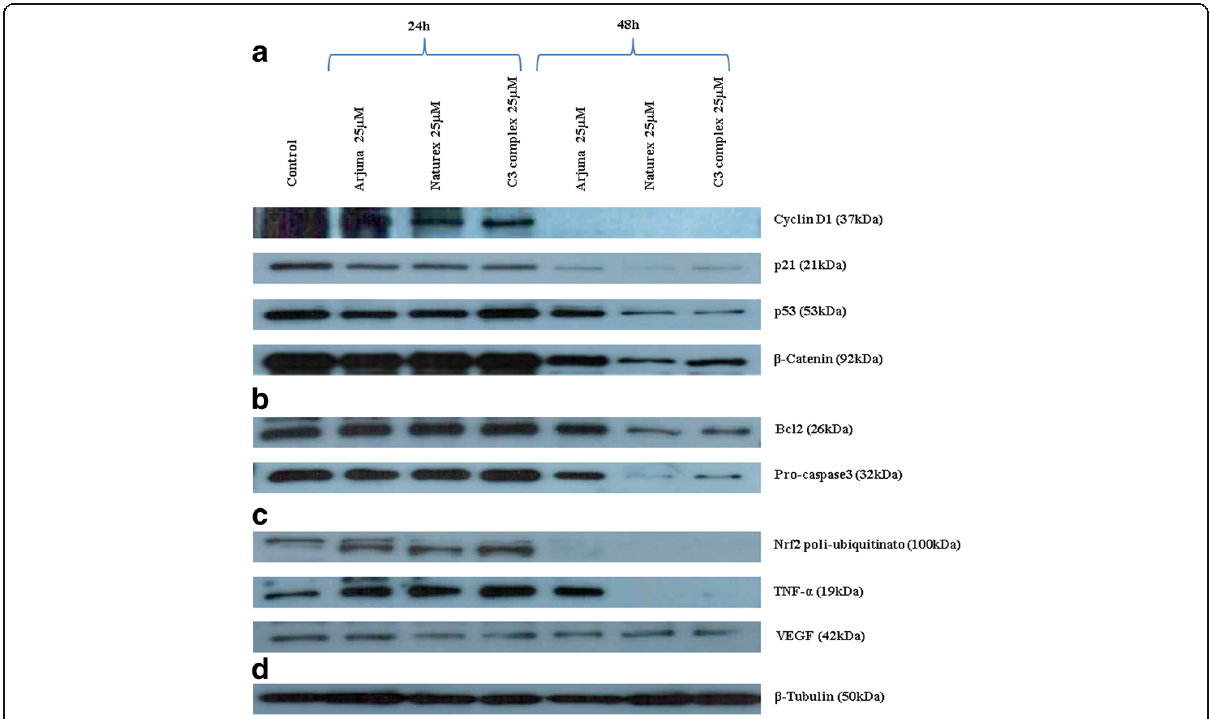
Fig. 1 Effects of three different extracts of Curcuma (Arjuna®, Naturex®, C3Complex®) on a papillary thyroid carcinoma cell line (TPC1), treated with 25 μ M for 24-48 h. Data obtained by Western blot, analyzing Cyclin D1, p21, p53, β -Catenin ( a ), Bcl2, pro-Caspase3 ( b ), Nrf2, Tnf- α , VEGF ( c ), β -tubulin ( d